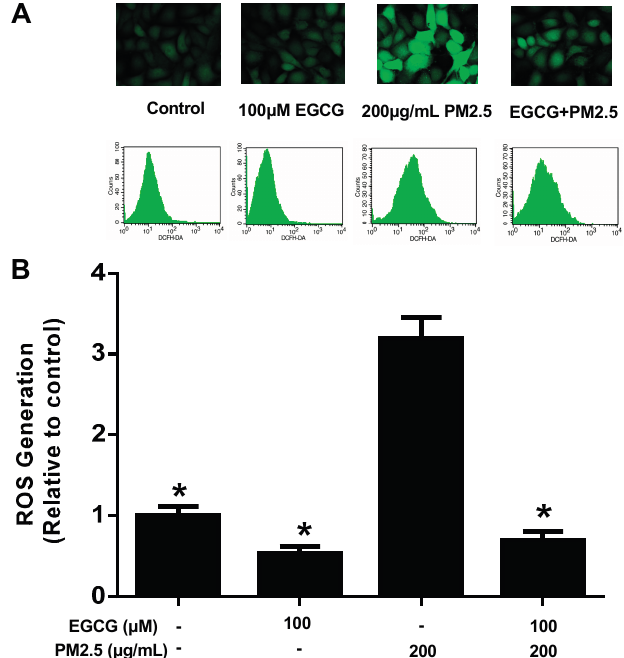
Figure 3. EGCG reduced PM 2.5 -induced ROS production in HUVECs. Intracellular ROS levels were determined using flow cytometry and DCFH 2 -DA. ( A ) Representative images and recordings. HUVECs were incubated without any intervention (control), EGCG alone, PM2.5 alone, or 100 μ M EGCG for 30 min followed by 200 μ g/mL PM 2.5 for